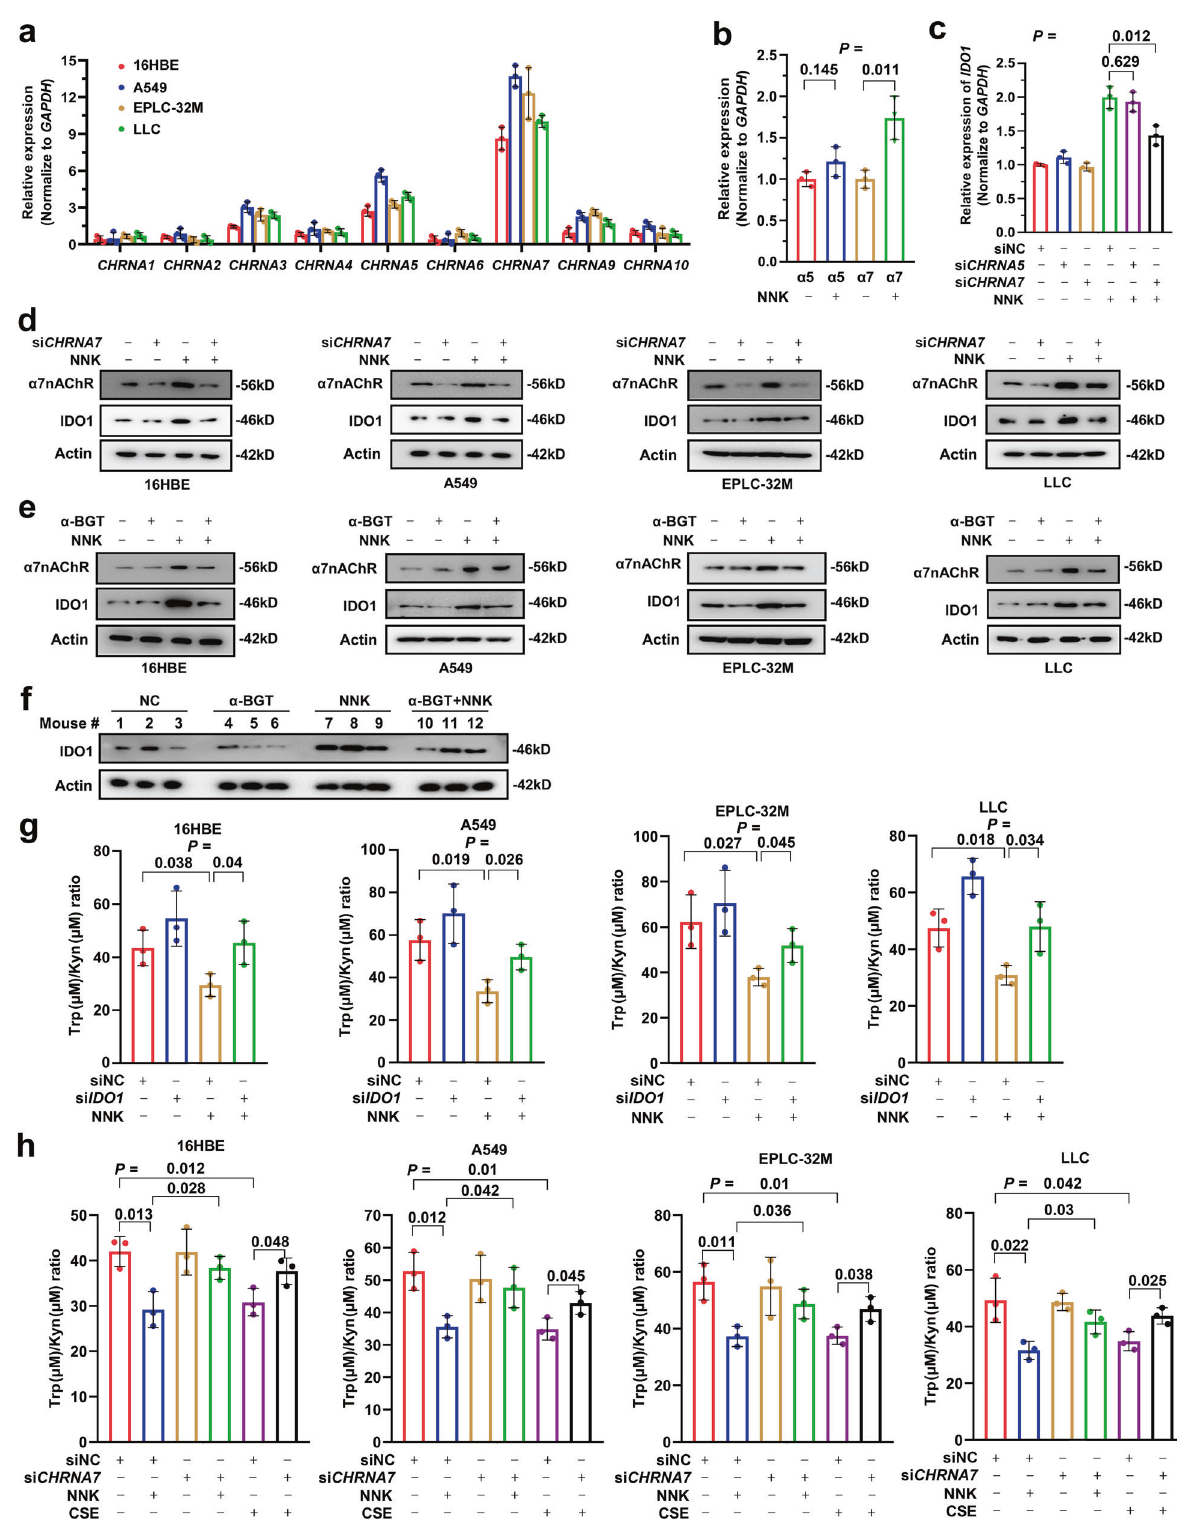
Fig. 4 α 7nAChR is required for NNK-induced IDO1 upregulation and Trp metabolism. a The expression of the nine NNK receptors in 16HBE, A549, EPLC-32M and LLC cells. b The expression of α 5nAChR- and α 7nAChR-coding genes in A549 cells treated with 25 μ M NNK for 72 h. c A549 cells were transfected with or without si CHRNA5 or si CHRNA7 and treated with 25 μ M NNK for 72 h, and the expression of IDO1 was detected by qRT-PCR. d , e The cells were pretransfected with si CHRNA7 ( d ) or pretreated with α -BGT ( e ), followed by treatment with 25 μ M NNK for 72 h. The cells were then lysed and subjected to western blotting using the indicated antibodies. f The A/J mice were treated with NNK and/or α -BGT for 90 days and sacri fi ced, and lung tissues were collected for western blot analysis. g The cells were transfected with si IDO1 and treated with 25 μ M NNK for 72 h, and the Trp/Kyn ratio was tested. h The cells were transfected with si CHRNA7 and treated with 25 μ M NNK or 10% CSE for 72 h, and the Trp/Kyn ratio was tested. P values, Student ’ s t test. Error bars, sd Signal Transduction and Targeted Therapy (2022)